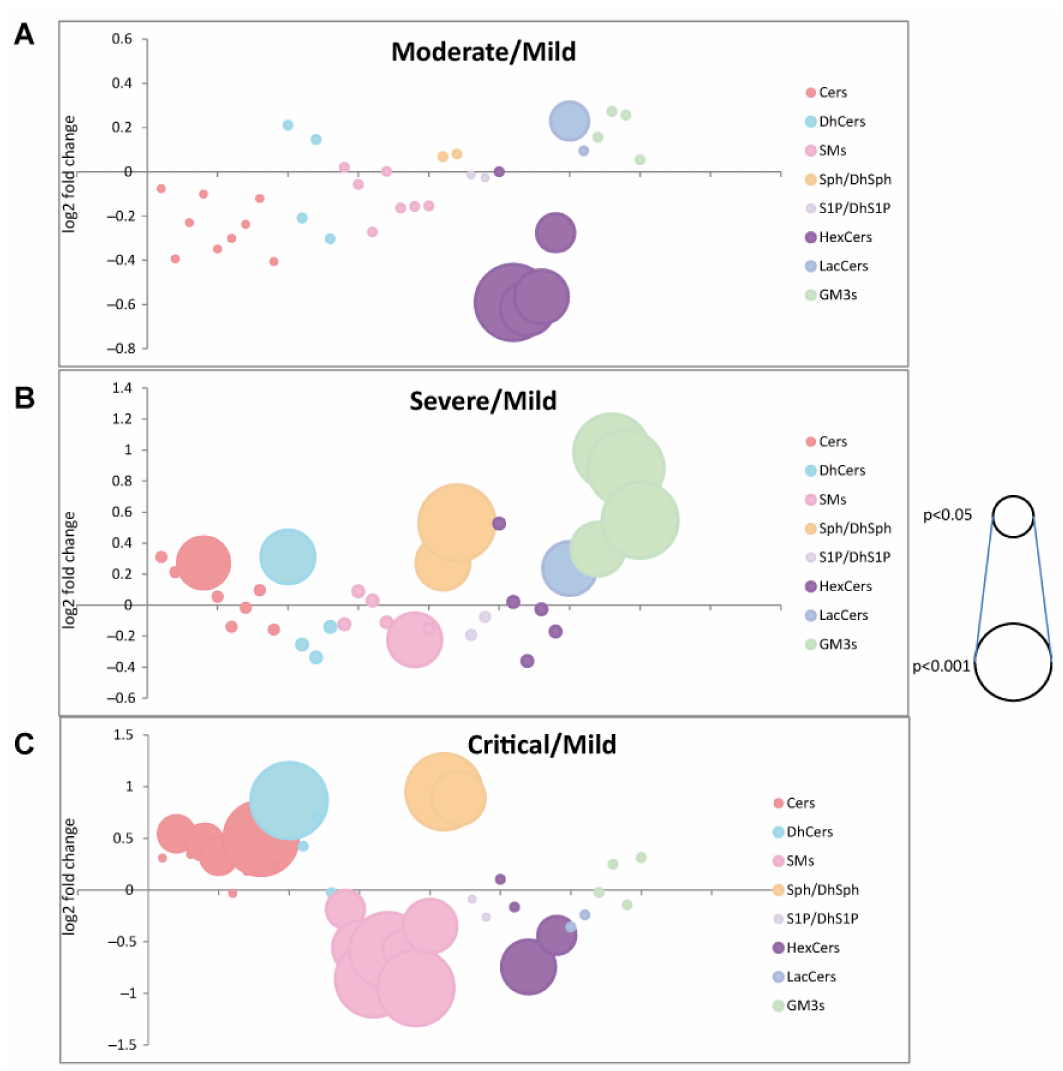
Figure 10. Bubble plots of log2 fold changes in abundance of sphingolipid species in serum from moderate ( A ), severe ( B ), and critical ( C ) patients compared to mild patients are shown. Bubble size represents the p -value from Kruskal Wallis